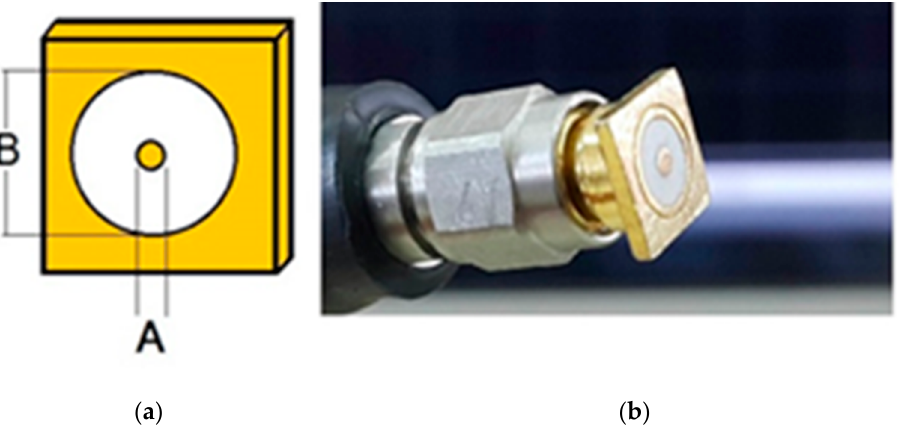
Figure 3. ( a ) The design of the modified SMA connector. ( b ) A photograph of the proposed